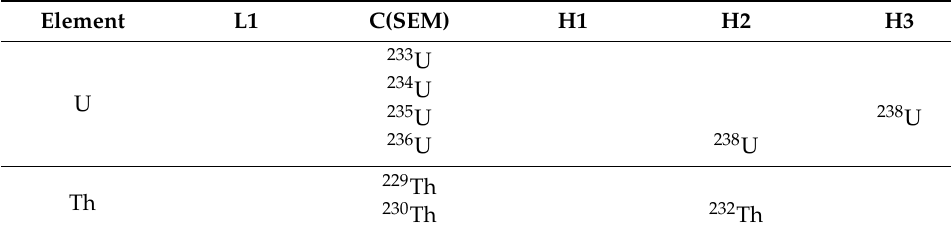
Table 3. Faraday cup configurations for measurement of U and Th by MC-ICPMS.